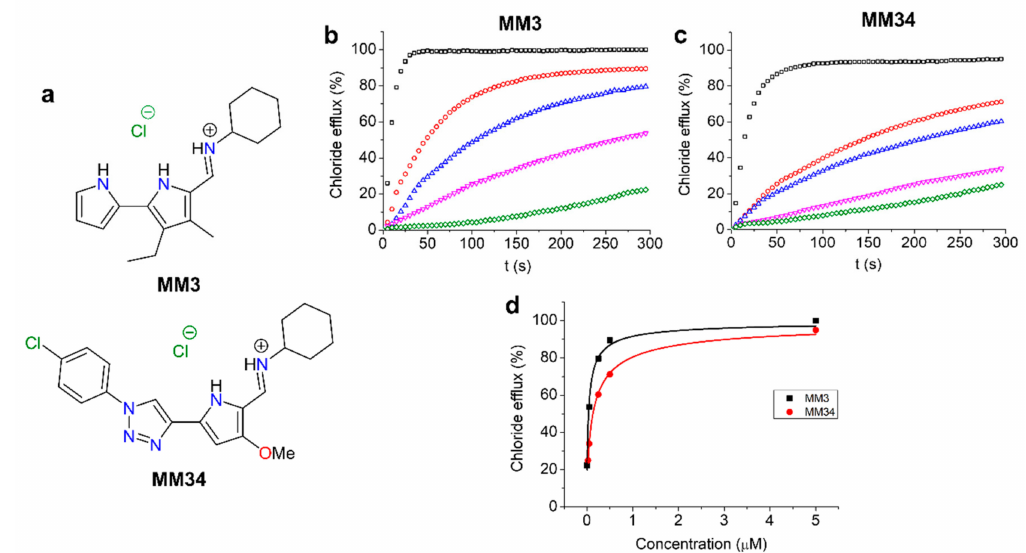
Figure 1. ( a ) Structures of the studied compounds. ( b ) Chloride e ffl ux promoted by compound MM3 (5 µ M, black; 0.5 µ M, red; 0.25 µ M, blue; 0.05 µ M, magenta; 0.005 µ M, green) in unilamellar 1-palmitoyl-2-oleoyl-glycero-3-phosphocholine (POPC) vesicles. Vesicles containing NaCl (451 mM NaCland20mMphosphatebu ff er, pH7.2)wereimmersedinNa 2 SO 4 (150mMNa 2 SO 4 , 40mMNaHCO 3 and 20 mM phosphate bu ff er, pH 7.2). Each trace represents the average of at least three di ff erent experiments. ( c ) Chloride e ffl ux promoted by compound MM34 (5 µ M, black; 0.5 µ M, red; 0.25 µ M, blue; 0.05 µ M, magenta; 0.025 µ M, green) in unilamellar POPC vesicles. The experimental conditions are identical to those reported for MM3. ( d ) Transport activity plotted againts the concentration for both compounds, in model liposomes, was fitted with the Hill equation, represented as a continuous